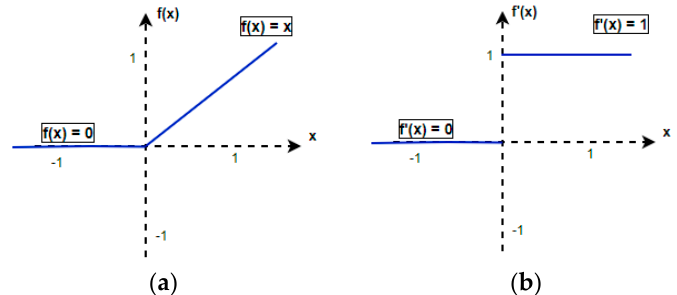
Figure 7. ( a ) Rectified linear unit (ReLU) activation function; ( b ) Derivative of ReLU.